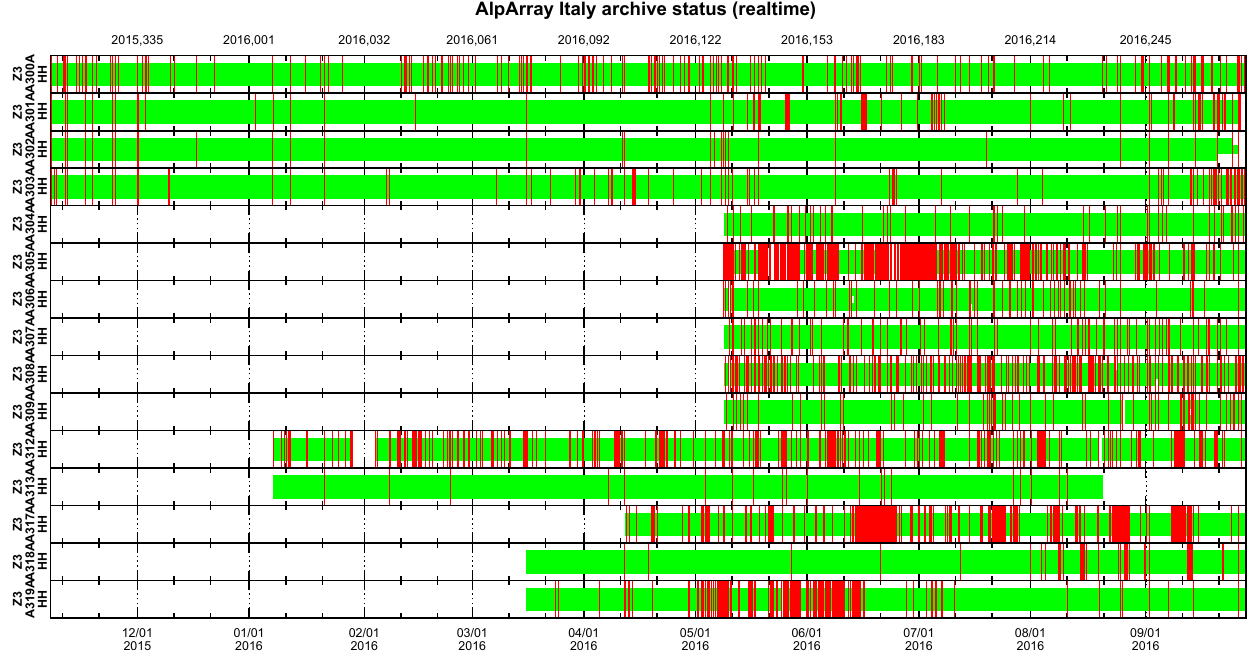
Figure 8. The real-time archive so far. Only 4 stations (Z3.A300A–Z3.A303A) were installed already equipped with UMTS routers. The equipment needed for real-time data transmission has been available for all stations only in spring 2016 and with all SIM cards from the same telephone company. At least 3–5 stations need to be optimized either installing a higher gain antenna or changing the service provider. This work will be done at the next scheduled maintenance around fall 2016. The overall completeness of the data archive is around 97%, very useful for monitoring the data quality and scheduling the station